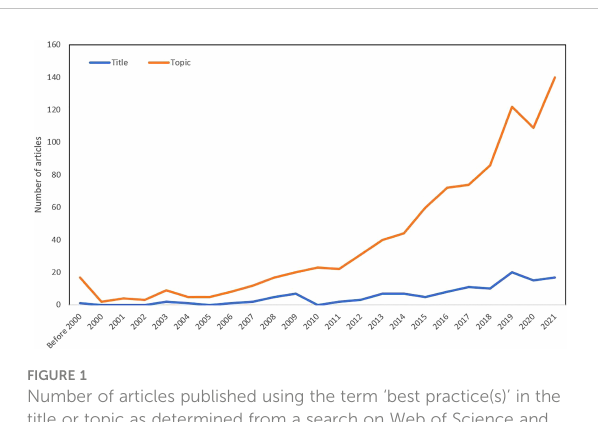
FIGURE 1 Number of articles published using the term ‘ best practice(s) ’ in the title or topic as determined from a search on Web of Science and fi ltering by disciplines (oceanography, marine freshwater